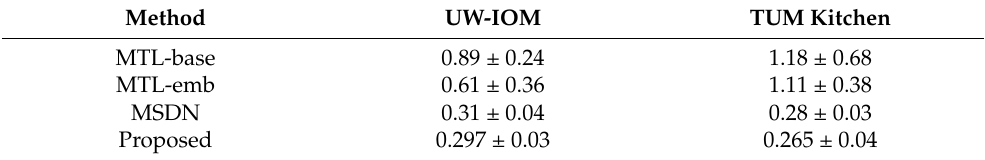
Table 3. Comparison against state-of-the-art approaches in the UW-IOM and TUM Kitchen datasets.